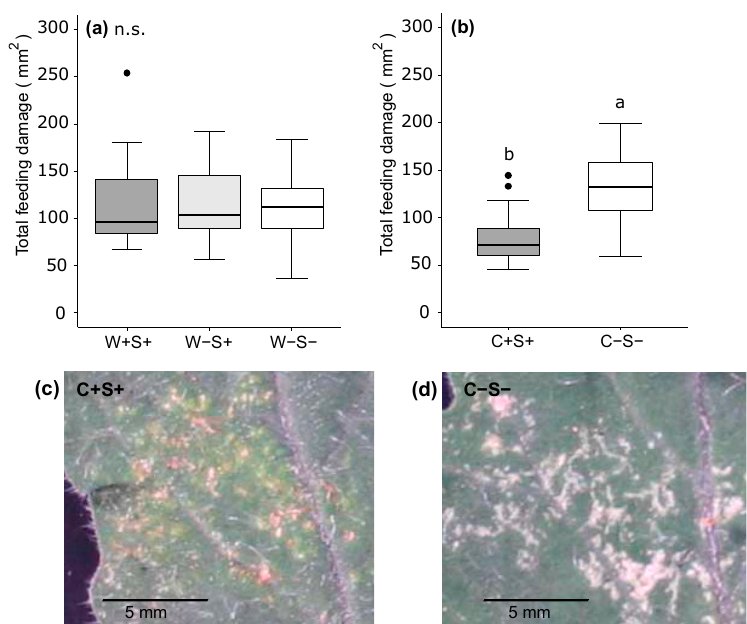
Figure 7. Feeding damage on tomato ( S. lycopersicum ) leaflets inflicted by two strains of the spider mite T. urticae which did (+) or did not ( − ) contain the bacteria Wolbachia (W), Spiroplasma (S) and/or Cardinium (C). Total amount of feeding damage (mm 2 ) after seven days of infestation by mites from ( a ) the DeLier-1 strain with three groups: W+S+, W − S+ and W − S − ; and ( b ) the Santpoort-2 strain with two groups: C+S+ and C − S − . Boxes span the 25–75 percentiles, horizontal lines in the boxes represent medians, whiskers span 1.5× IQR, dots represent data points outside of this range. Different letters above the boxes indicate significant differences at a level of p ≤ 0.05, n.s.: not significant; ( c ) Typical rusty red/brown scars inflicted by feeding of the C+S+ group of the Santpoort-2 strain and ( d ) typical white scars inflicted by feeding of the C − S − group of the Santpoort-2 strain.